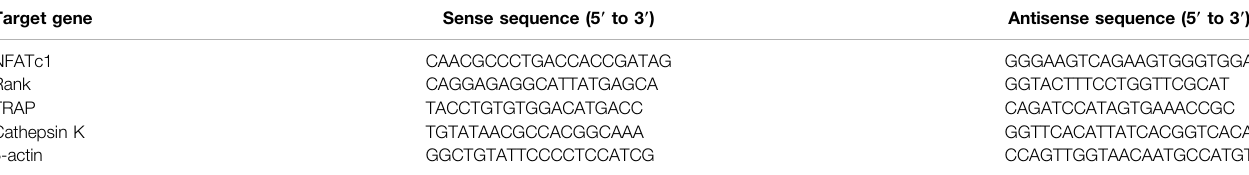
TABLE 1 | List of primers used in quantitative real-time RT-PCR. Target